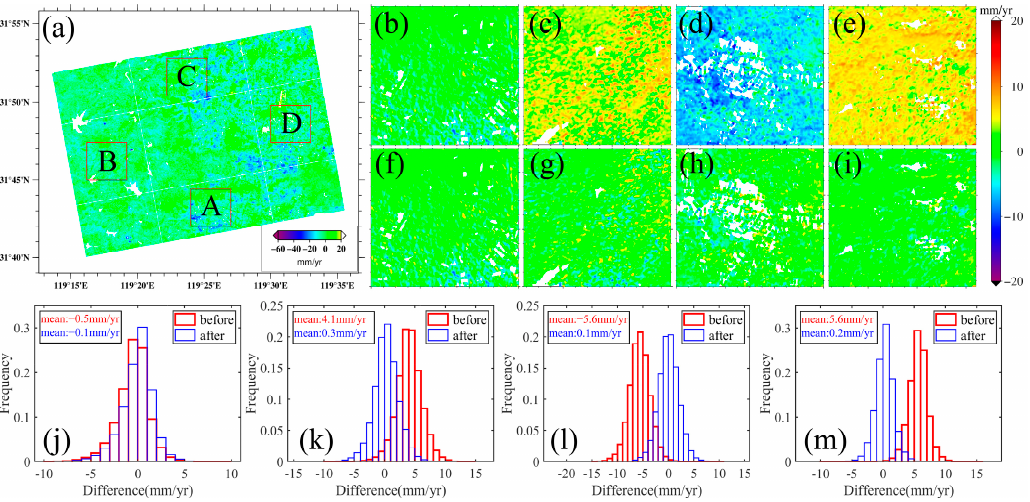
Figure 8. The difference in the homonymy points before and after adjustment in regions A, B, C, and D of Changzhou. ( a ) shows the location of the four regions. ( b – e ) Are the difference of the overlapping areas before adjustment in regions A, B, C, and D, and ( f – i ) are the difference after adjustment. ( j – m ) Shows the statistical histograms of the four regions.